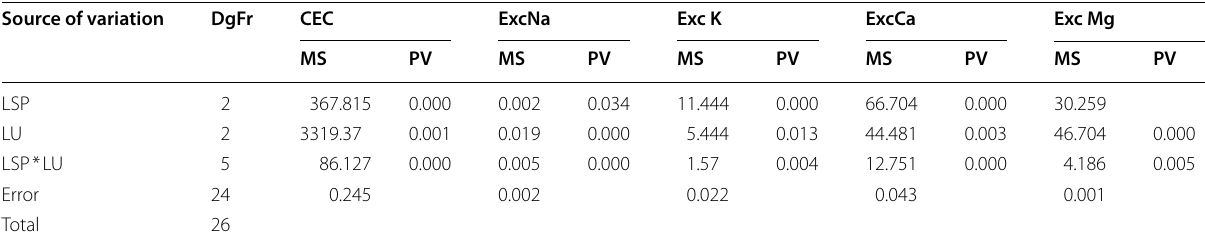
MS is the mean square, PV is p-value, DgFr is the degree of freedom